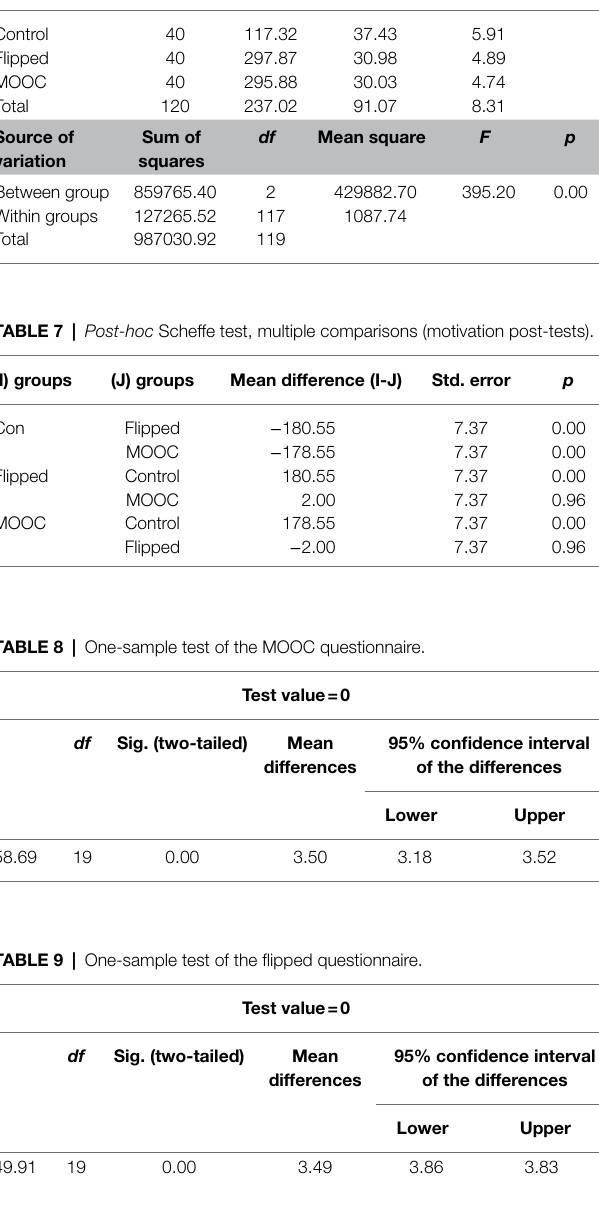
TABLE 6 | ANOVA results for motivation post-test. Groups